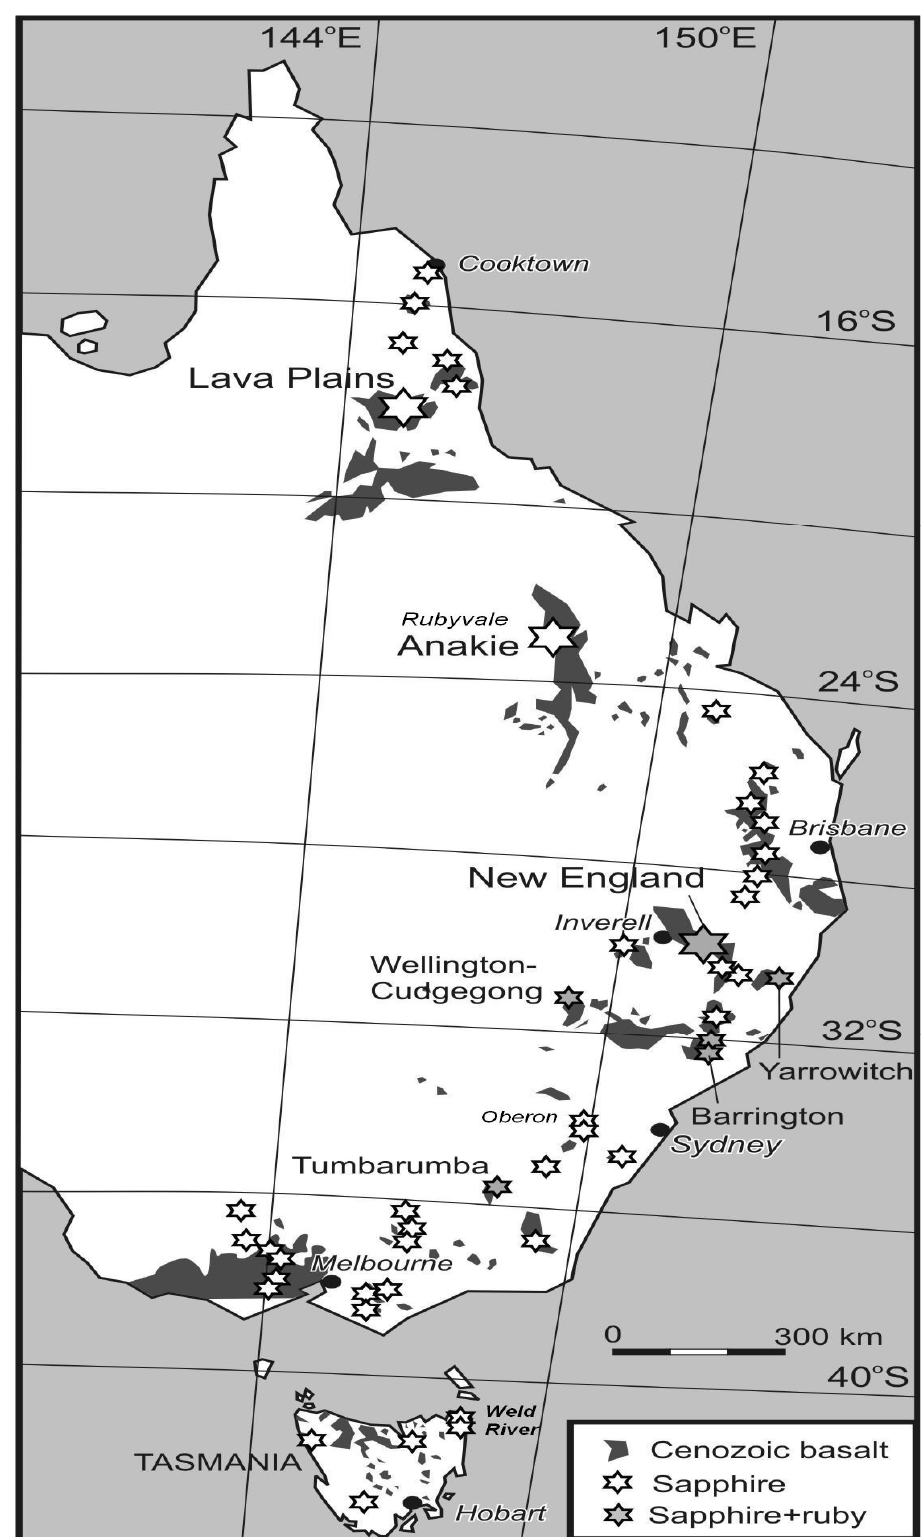
Figure 5. East Australian basalt-derived alluvial gem corundum deposits, showing ruby and locating Barrington Tops, Macquarie River (Wellington) and New England comparative sites. Map derived from reference [9].